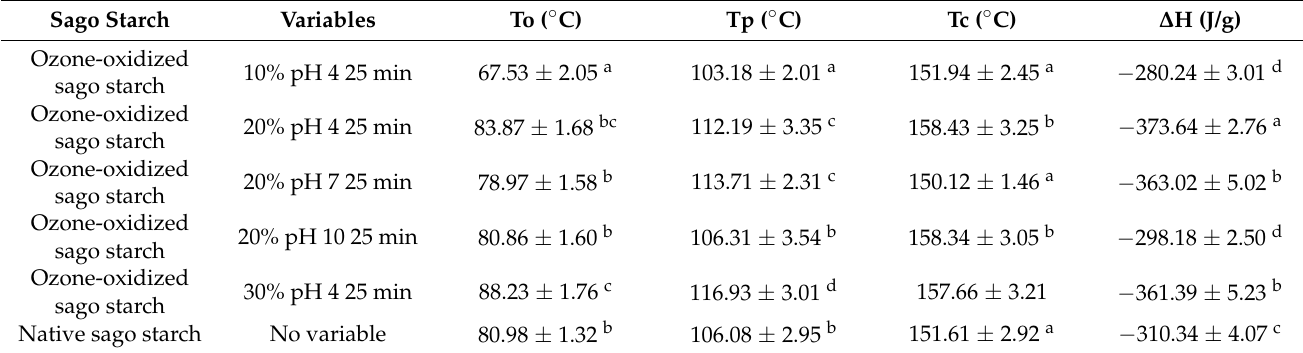
Table 1. Thermal properties of native and ozone-oxidized sago